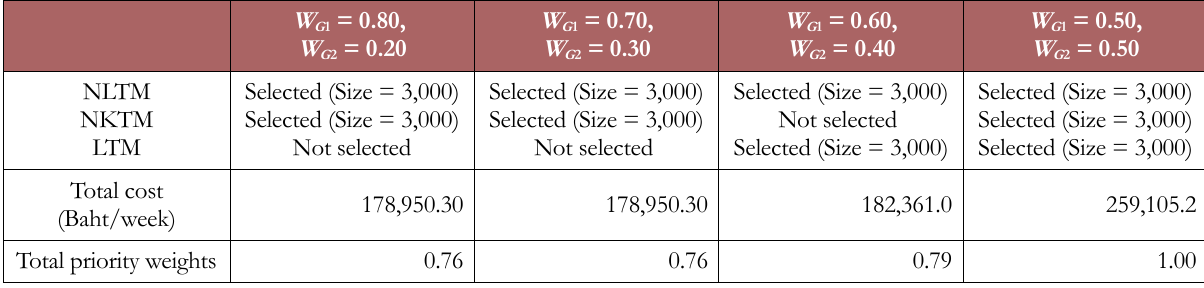
Table 8. Sensitivity analysis for different values of objective’s